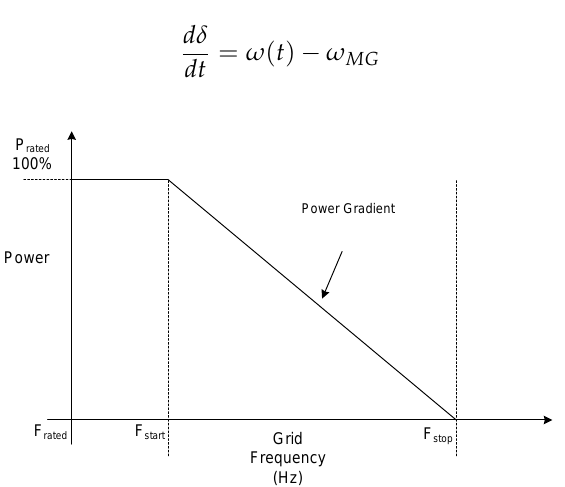
Figure 13. Power gradient diagram for active power (P) versus frequency (F) control function in the PV inverter.